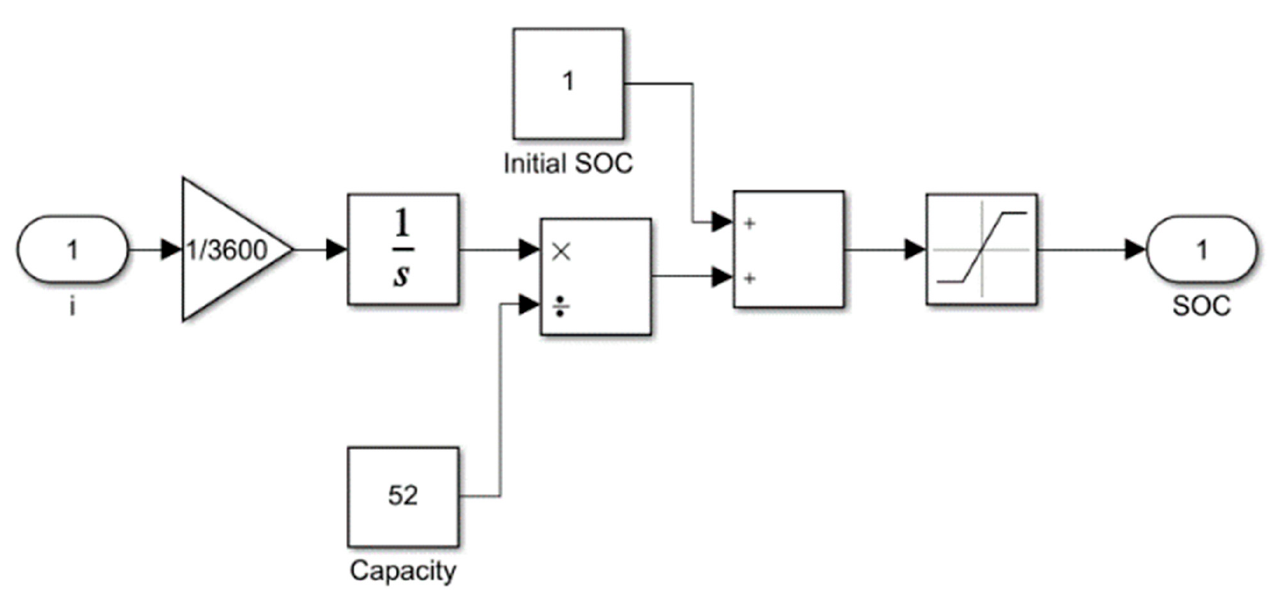
Figure 3. Terminal voltage calculation submodule of the second-order RC circuit.